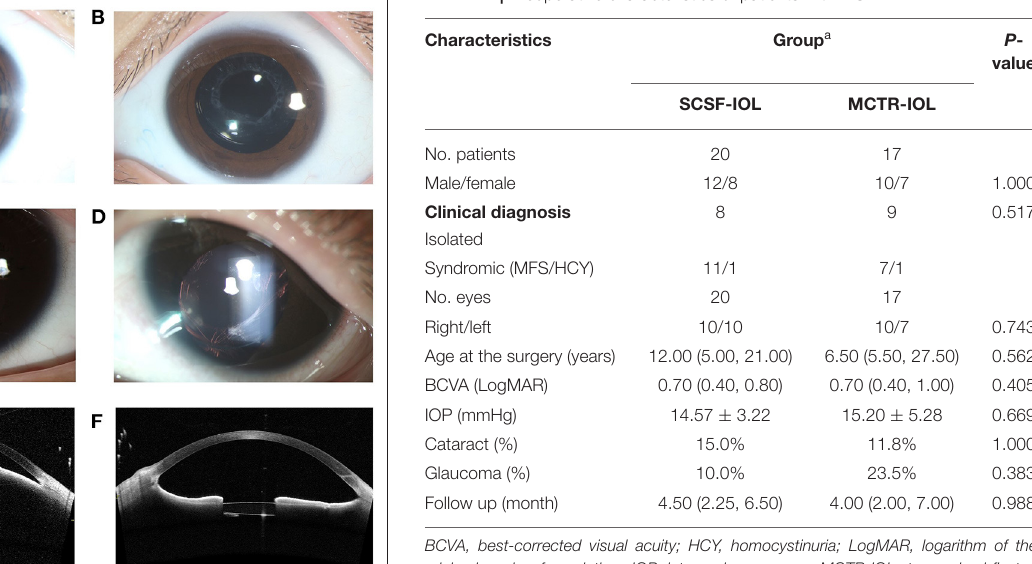
TABLE 1 | Preoperative characteristics of patients with